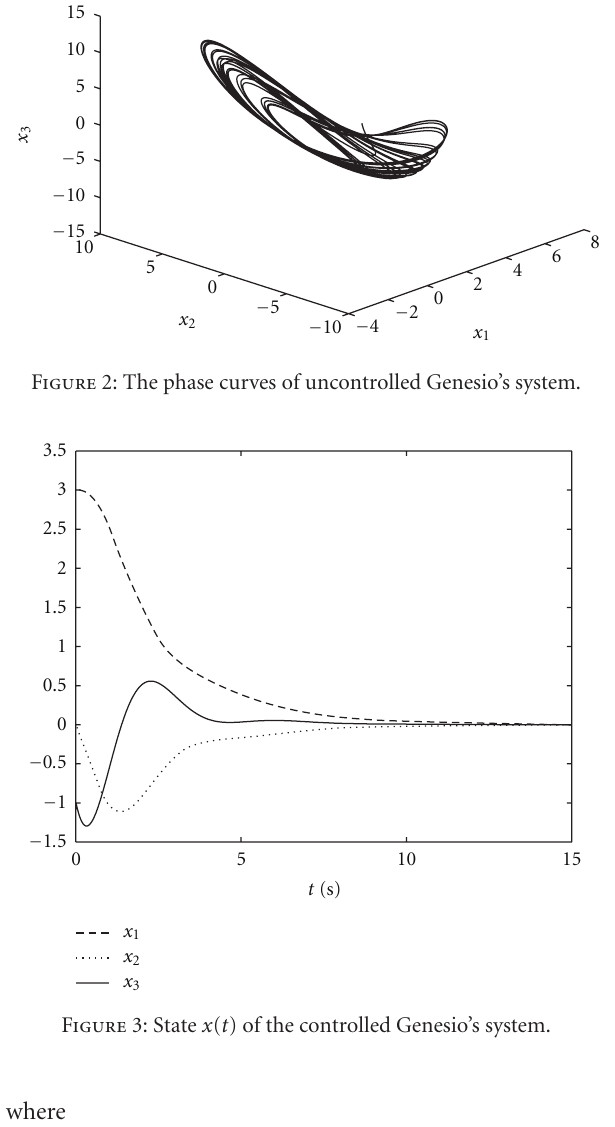
Figure 5: Sliding mode s ( t